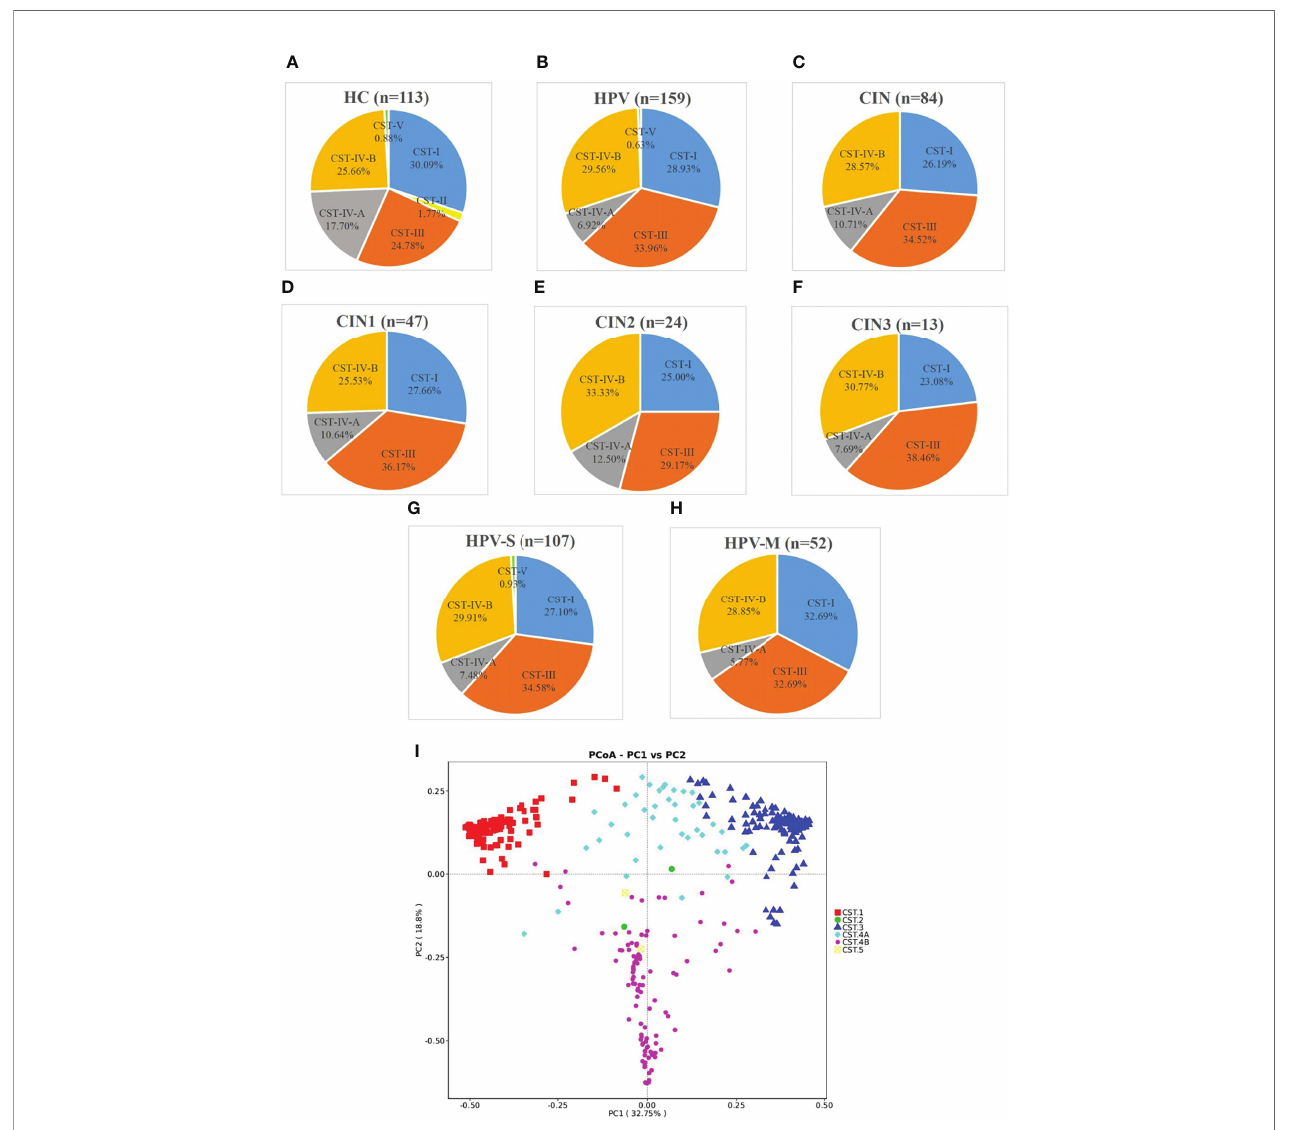
FIGURE 5 | Samples were classi fi ed by CST and principal coordinates analysis (PCoA) of microbiota data based on Bray – Curtis distance of vaginal microbiota. (A – H) According to community state types (CSTs), the VMB of women was divided into I-V subtypes (n, the number of samples; HC, healthy control group; HPV, HPV-infected group; CIN, CIN-diagnosed group; HPV-S, HPV simple infection group; HPV-M, HPV multiple infection group; CIN1, CIN1 group; CIN2, CIN2 group; CIN3, CIN3 group). (I) Principal coordinates analysis (PCoA) of microbioal species data based on Bray – Curtis distance matric demonstrated six main vaginal microbiota